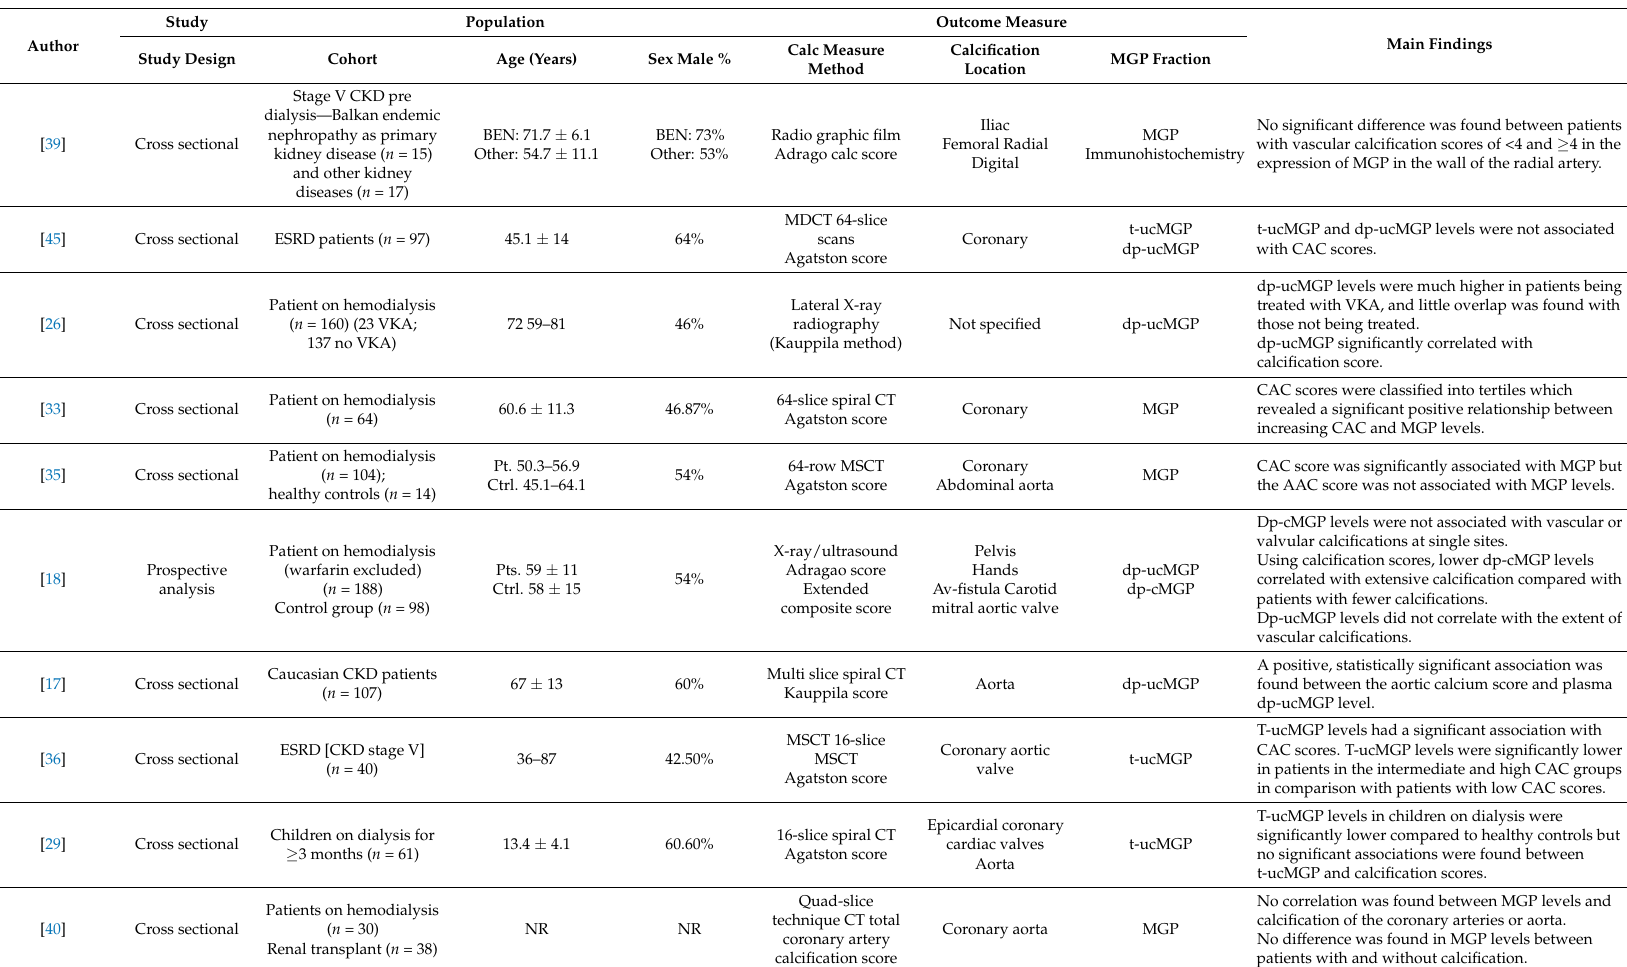
Table 3. Association between MGP fractions and vascular calcification in chronic kidney disease